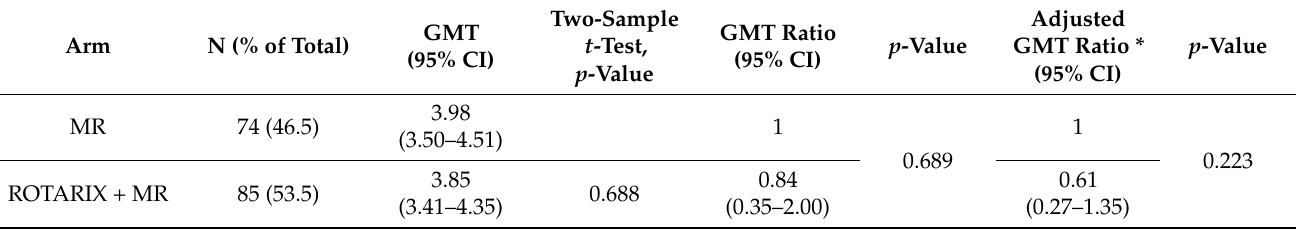
Table 2. Rotavirus IgA geometric titre mean ratio at 12 months by study arm.